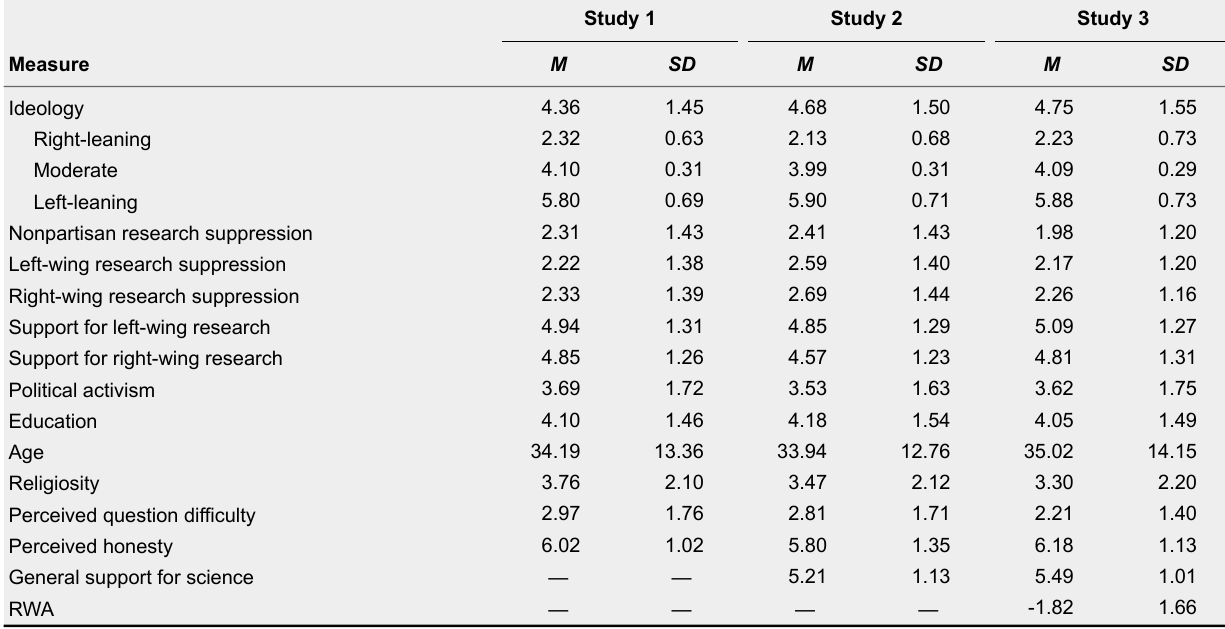
Means and Standard Deviations for